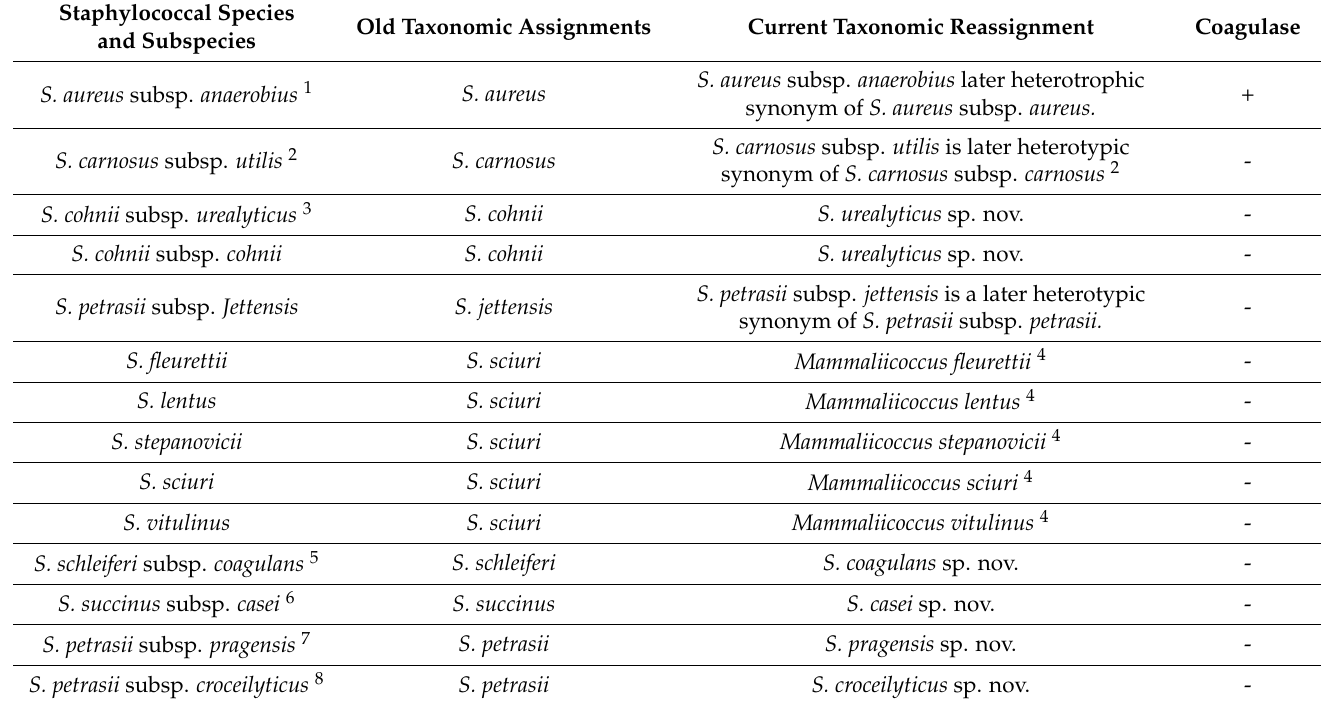
Table 1. Recent reclassification of members of the genus Staphylococcu s (Adapted from